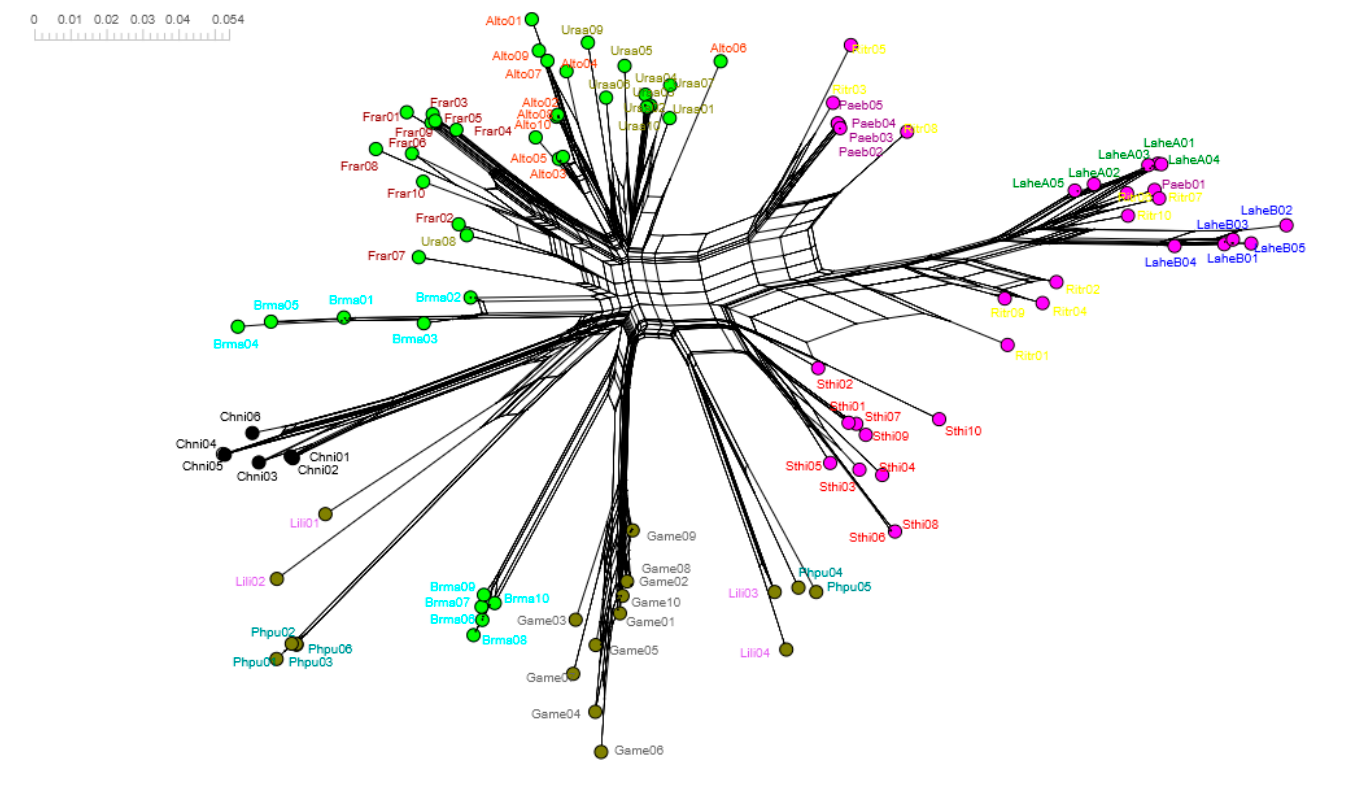
Figure 8. Neighbor-net phylogenetic network for MHCIIB alleles in Charadriiformes. Families Laridae (magenta dots), Alcidae (green dots), Scolopacidae (olive dots), and Charadriidae (black dots) are shown. Labels in each case show the sequences belonging to the species analyzed (i.e., Lahe— Larus heermanni ; see methods).